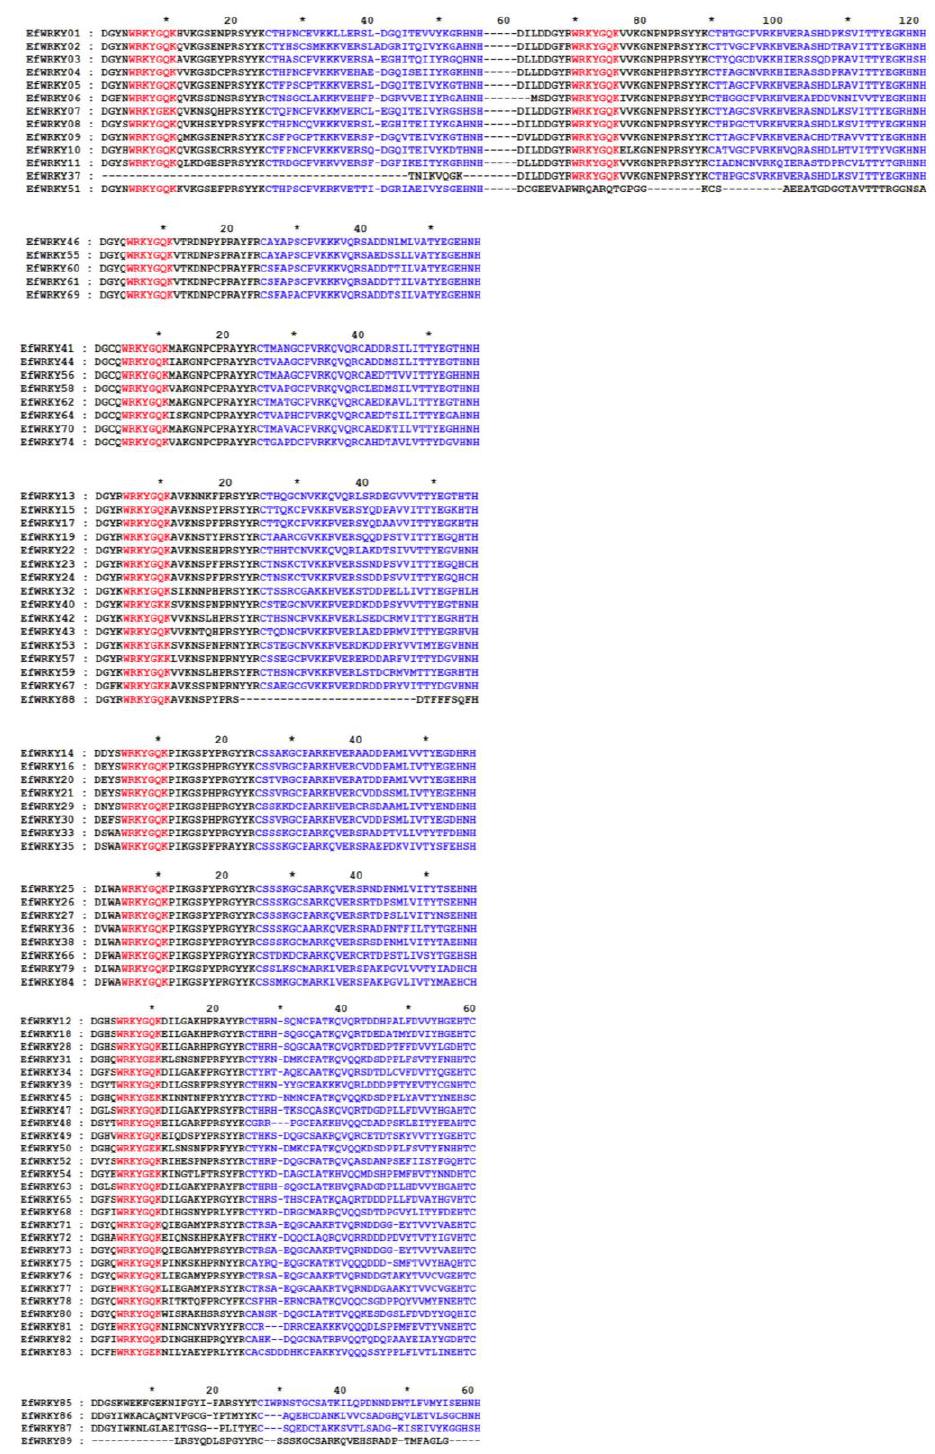
Figure 1. Sequence alignment of the WRKY structural domain of the 89 WRKY proteins in E. fulvus . The red part is the highly conserved heptapeptide of the protein, and the blue part is the zinc finger structure of the